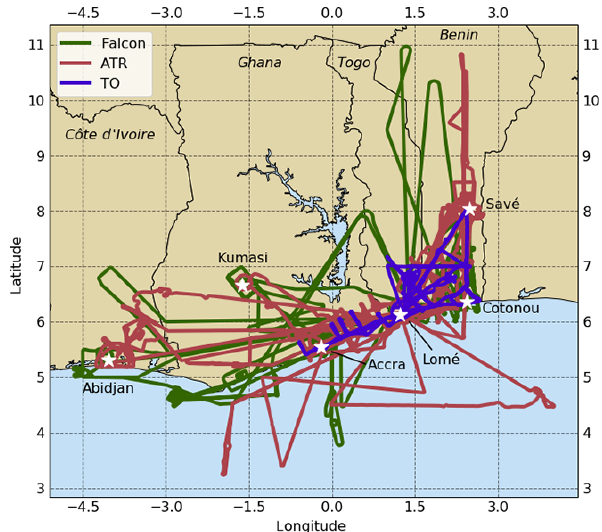
Figure 1. Map showing the flight paths of the Falcon, ATR and Twin Otter aircraft during the DACCIWA